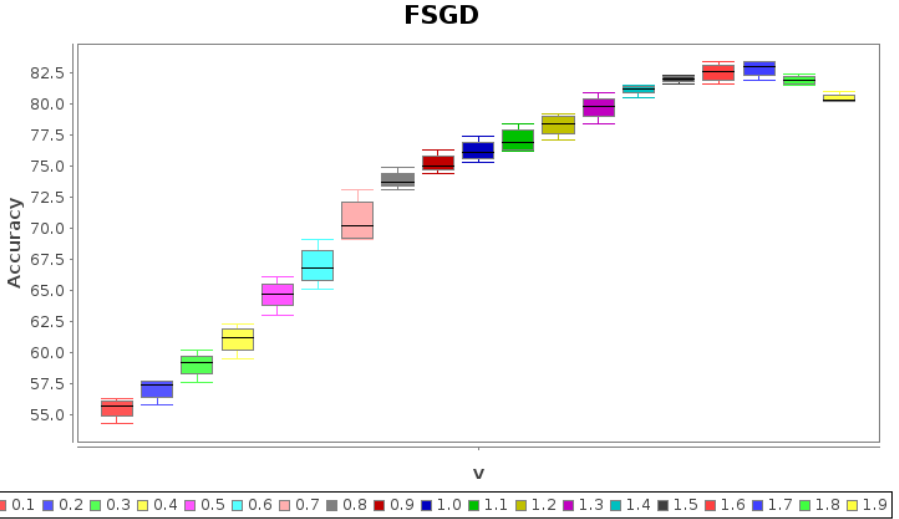
Figure 4. The highest score for FSGD is 82.8% at ν = 1.7.